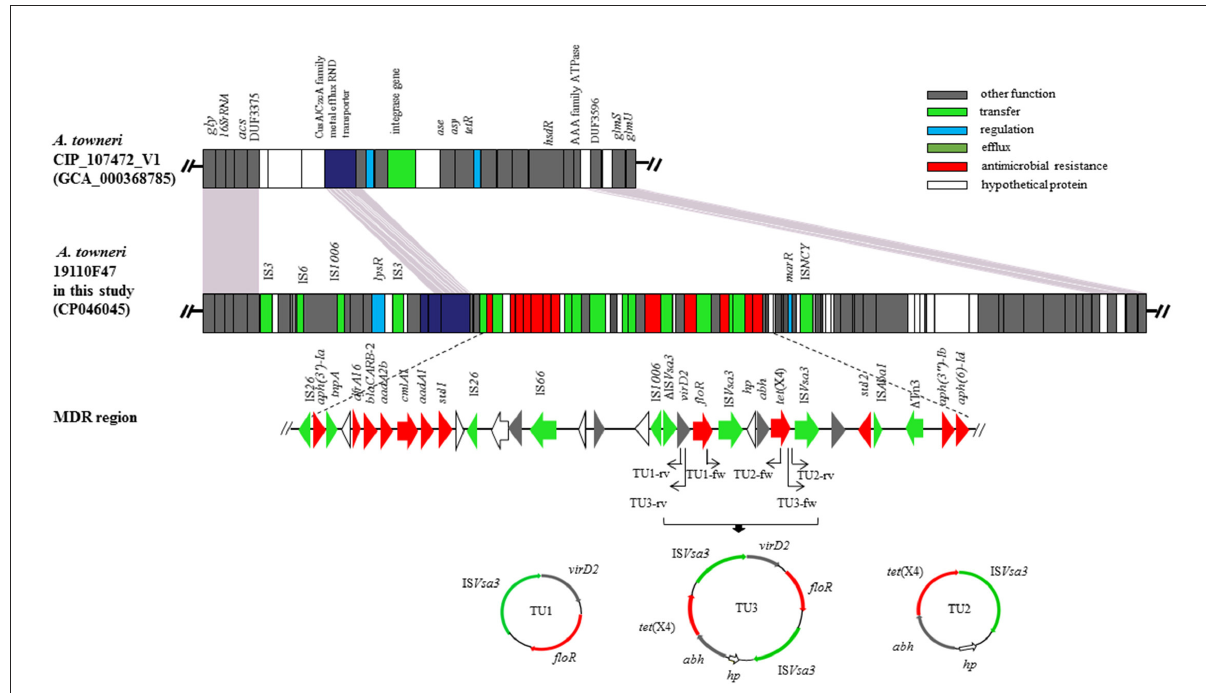
FIGURE1 The genomic island carrying of the tet (X4) gene in the chromosomal DNA of A. towneri 19110F47 in this study. Genes are indicated by different colors. 1 indicates that the gene is truncated. The primers used for PCR were shown by arrows. Three TUs, including TU1 ( vir D2- floR -IS Vsa3 , 4,274 bp), TU2 [ hp-abh-tet (X4)-IS Vsa3 , 4,608 bp] and TU3 [ vir D2- floR -IS Vsa3 - hp - abh-tet (X4)-IS Vsa3 , 8,882 bp] were